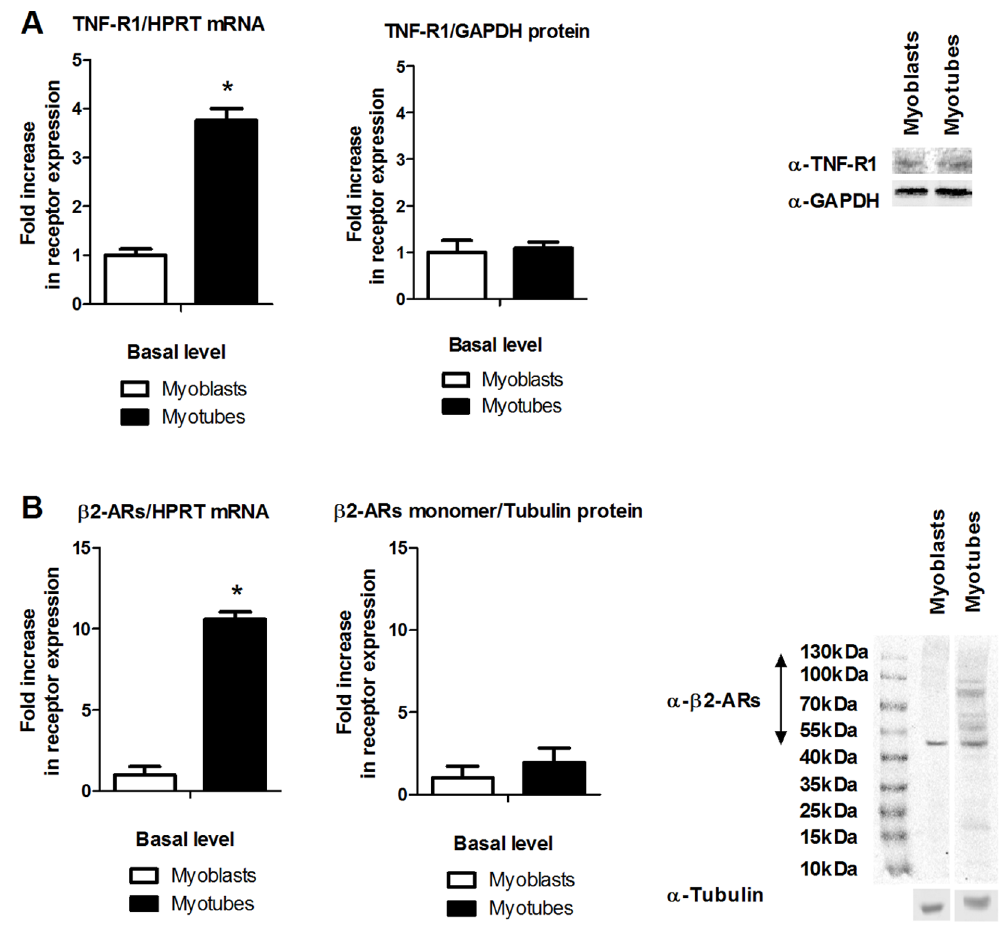
Figure 1. Expression of TNF-R1 and b 2 -AR in C2C12 myoblasts and myotubes. The basal expression of TNF-R1 (A) and b 2 -AR (B) mRNA and protein was compared in C2C12 myoblasts versus myotubes using RT-qPCR and Western blotting. RIPA lysates were prepared and equal amounts of protein were loaded on gel. Bar charts represent average 6 SD of densitometric analysis of three independent experiments. (For the b 2 -AR Western blot only the monomeric form of the receptor was densitometrically quantified.) A representative blot is shown. (*) significantly different from myoblasts using student’s t-test.